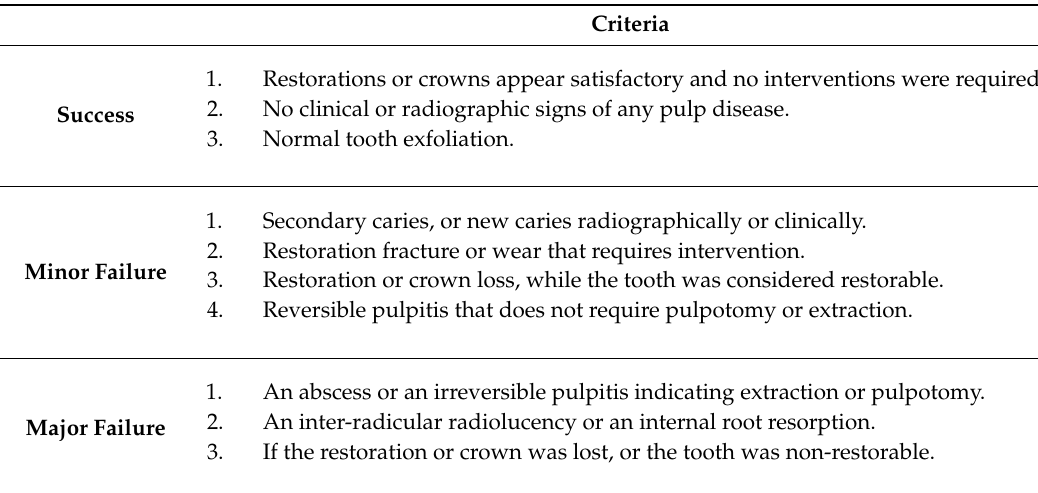
Table 3. Success and failure criteria of conventional restorations and the Hall technique crowns according to Innes et al.